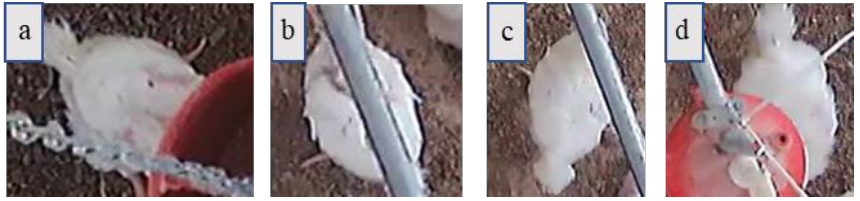
Figure 5. Examples of common equipment occlusions: ( a ) feeder occlusion; ( b ) water pipe occlusion– two areas (TA); ( c ) water pipe occlusion–one area (OA); ( d ) water pressure regulator occlusion.